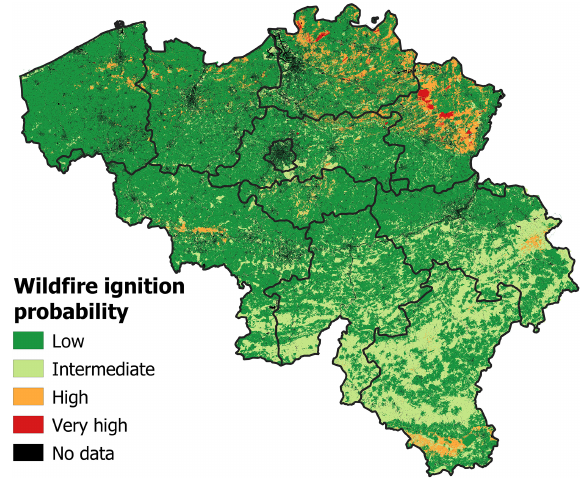
Figure 10. The ignition probability map constructed with land cover class, soil type, and land use